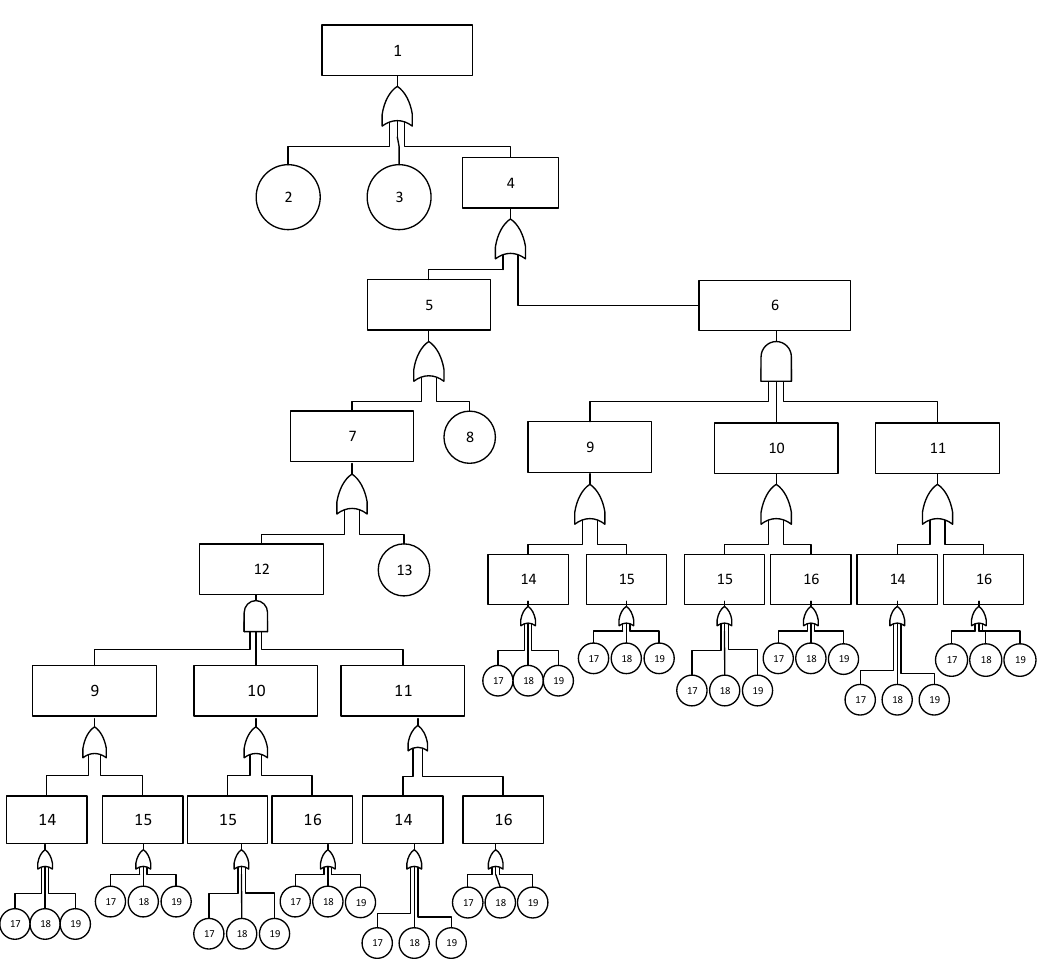
Figure A4. Fault tree of reactor scram failure activated by the position signal of the primary isolation valve. Note: 1 = reactor fail to scram. 2 = control rods insertion fail (B1). 3 = contact 6 system fail (B2). 4 = no signal. 5 = no scram manually. 6 = no scram from automatic system. 7 = the operator does not receive an alarm. 8 = operator fail (B7). 9 = detector system of JAA-01 CL 811 and 821 fail. 10 =